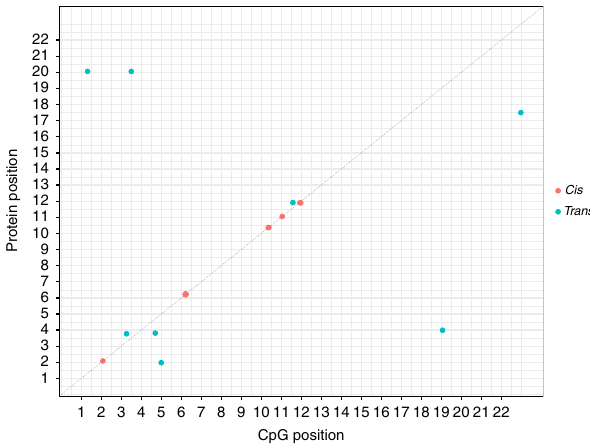
Fig. 3 Genomic locations of CpG sites associated with differential neurological protein levels. The x -axis represents the chromosomal location of CpG sites associated with the levels of Olink ® neurology biomarkers. The y -axis represents the position of the gene encoding the associated protein. Notably, cis CpG sites ( n = 17) identi fi ed by our EWAS on protein levels lay within the same cluster for a given protein. Some of these CpG sites lay too close to discriminate, resulting in the appearance of 5 cis CpG clusters in this fi